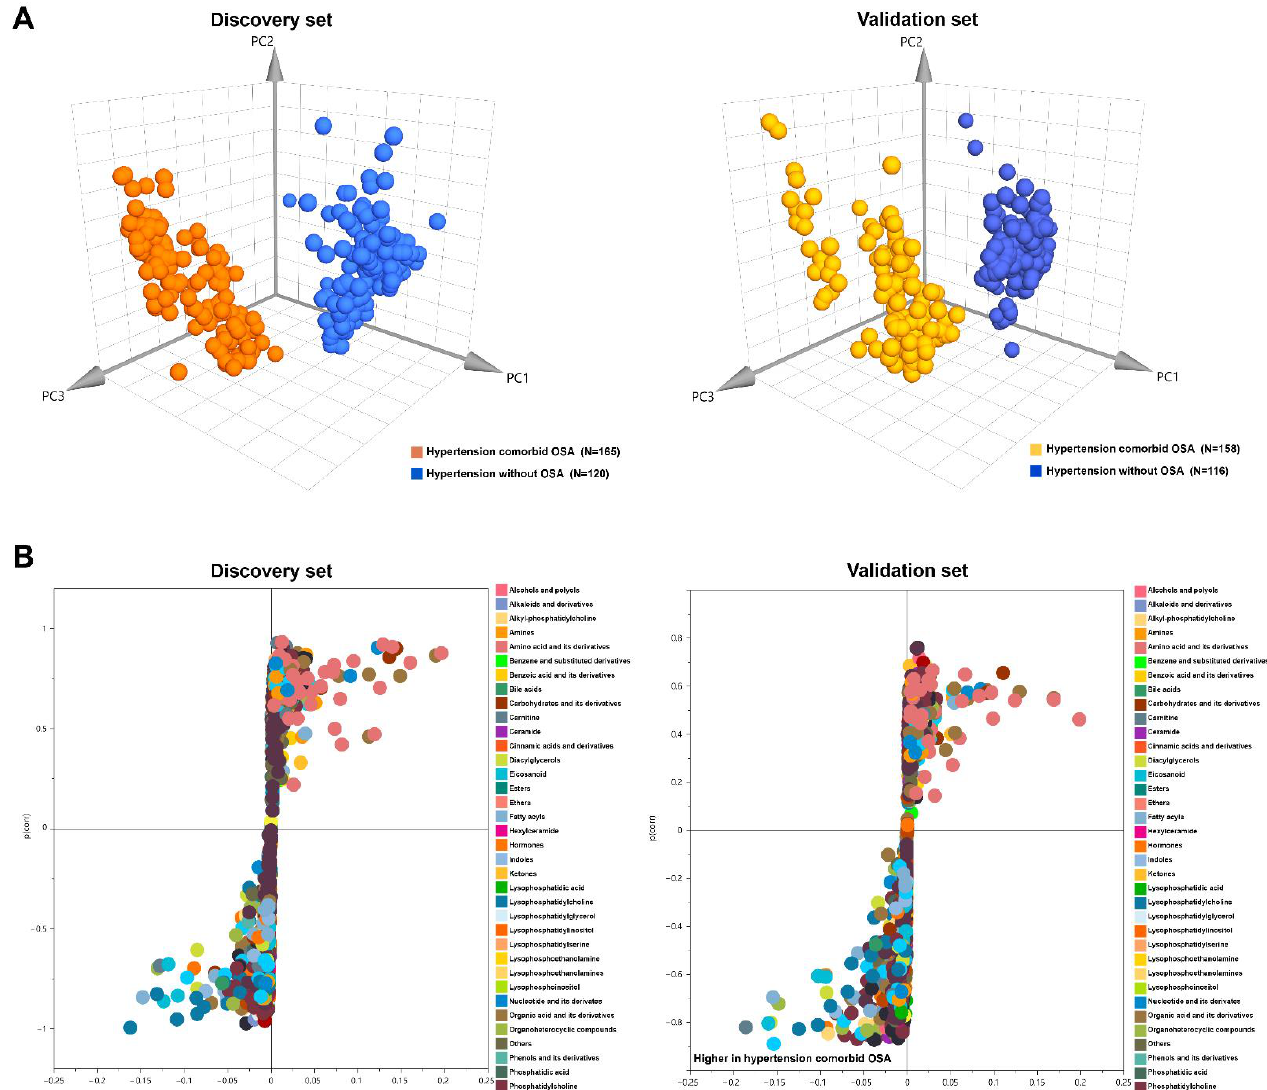
Figure 2. Multivariate statistical analysis of metabolic profiling data from discovery and validation sets. ( A ) Principal component analysis score plots showing apparent separation of patients with hypertension comorbid OSA from hypertensive patients without OSA. Each point represents an individual serum sample. ( B ) S − plot of orthogonal partial least squares discriminate analysis depicting remarkable metabolic signatures between hypertensive patients with OSA and those without OSA. Upper right zone: metabolites that are more abundant in hypertension without OSA in comparison to hypertension comorbid OSA. Lower left zone: metabolites that are more abundant in hypertension comorbid OSA in comparison to hypertension without OSA. Color coding on the left represents the different metabolite families.